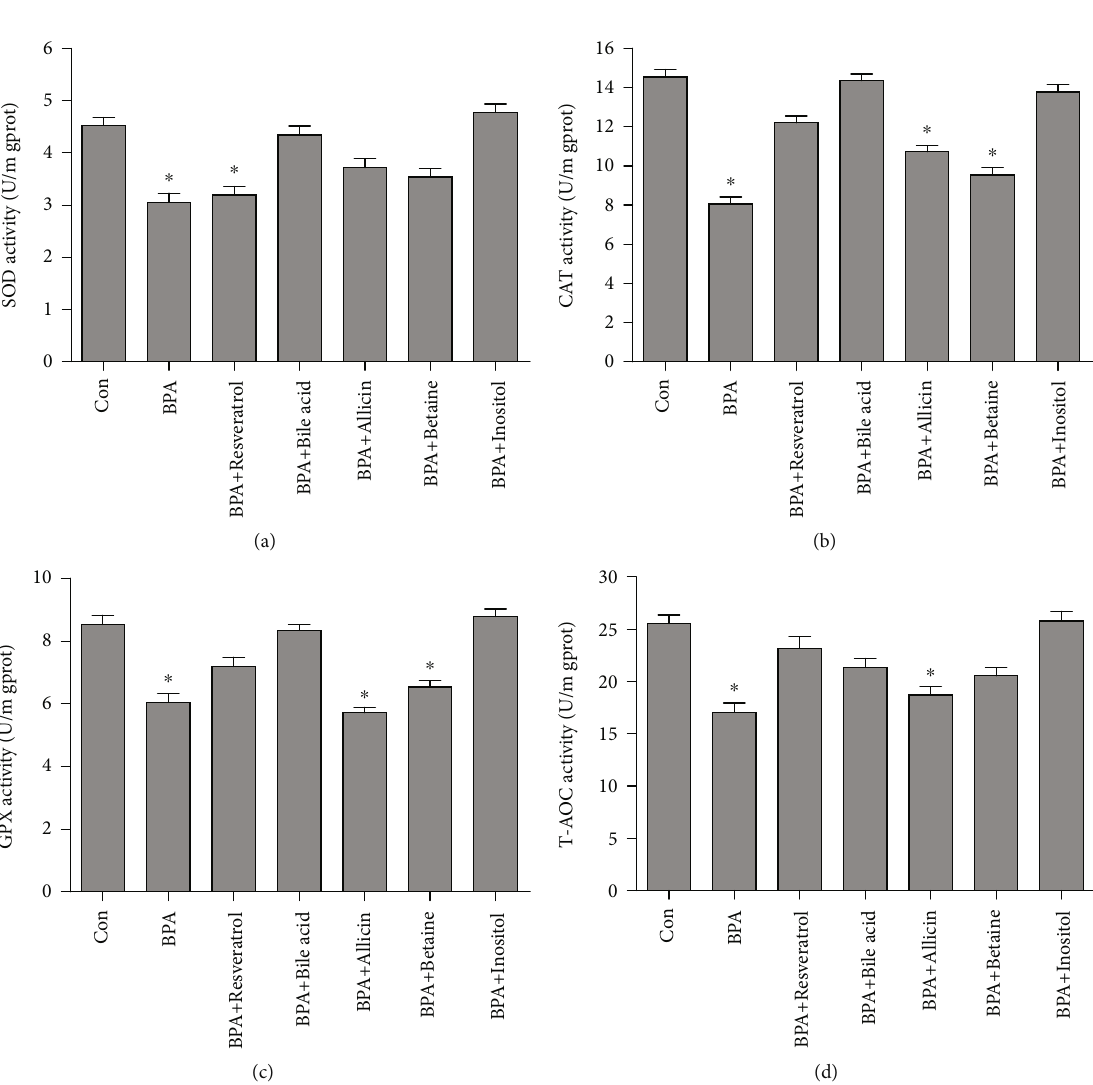
Figure 5: Antioxidant enzyme activities in rare minnow liver following BPA and experimental additives treatment. (a) SOD; (b) CAT; (c) GPX; (d) T-AOC. All statistical data were expressed as mean ± SD ( n =3). ∗ stands for there is a signi fi cant di ff erence between the treatment groups and Con groups ( P < 0 : 05